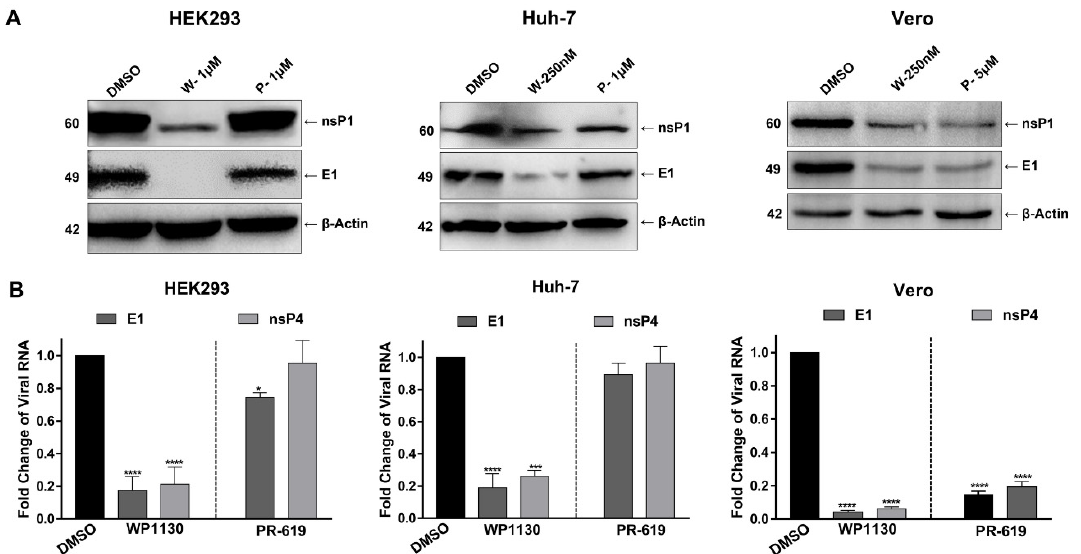
Figure 4. Inhibition of deubiquitinating enzymes impairs protein and viral RNA synthesis. Cells were pre-treated with the inhibitors WP1130 (W) or PR-619 (P) at the indicated concentrations, then infected with CHIKV for 1 h; after this time, the inoculum was removed and replaced with fresh media supplemented with inhibitors. After 24 h of infection, cells were collected. ( A ) Viral protein levels were evaluated using Western blot with antibodies against E1 and nsP1. β -actin was used as a loading control. ( B ) Levels of intracellular viral RNA were measured using RT-qPCR. Data are represented as the mean + SD, and statistically significant differences are indicated as * p < 0.05, *** p < 0.001, **** p < 0.0001.